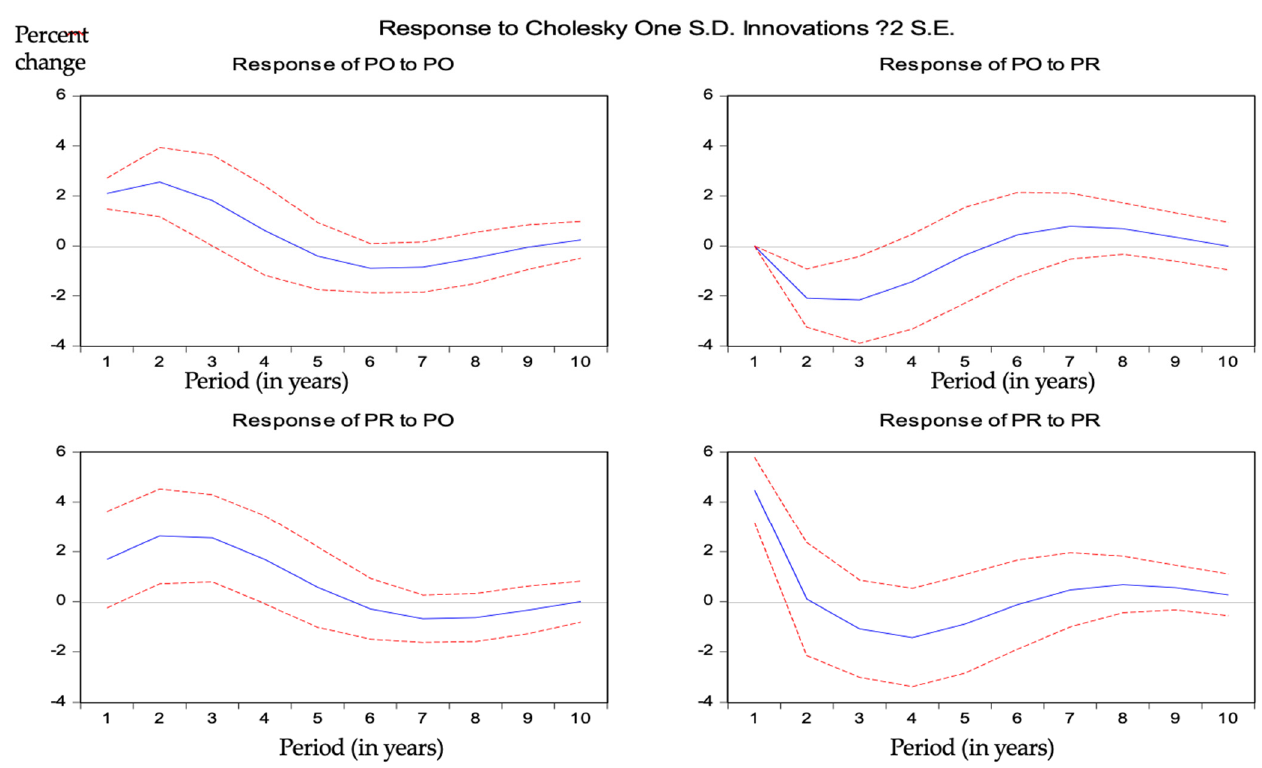
Figure 3. Impulse response functions. Note: PR denotes the price of recycled plastic; PO represents the price of crude oil. An impulse response function is considered significant when its upper band and lower band are both above zero or both below zero. Here, the upper band and lower band of a plastic recyclable price index (PR) to crude oil price (PO) are both above zero, leading to a positive effect at lag 2 and 3, which means that if crude oil price increases, recycling effort also increases after 2 or 3 years if all things been equal.